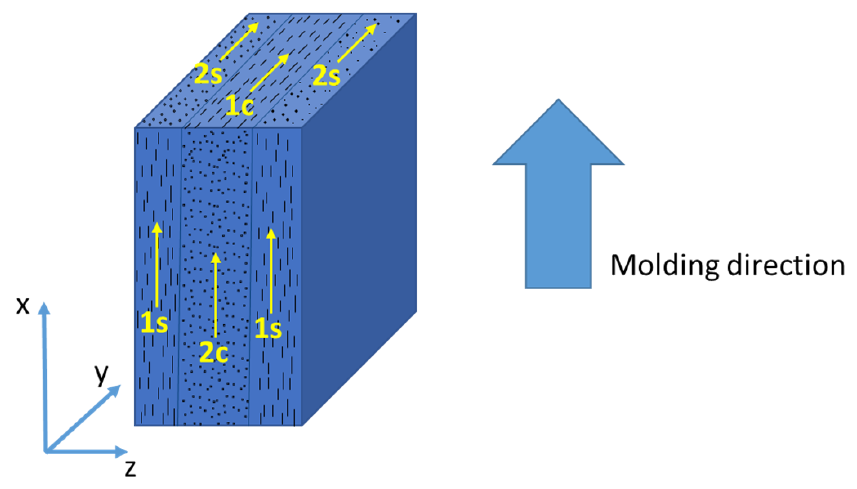
Figure 2. Global and local coordinate systems of injection molded plates: x—molding direction, y—transverse to molding direction, z—thickness direction, s—shell layer, c—core layer, 1—mean fiber direction, 2—transverse to mean fiber direction.